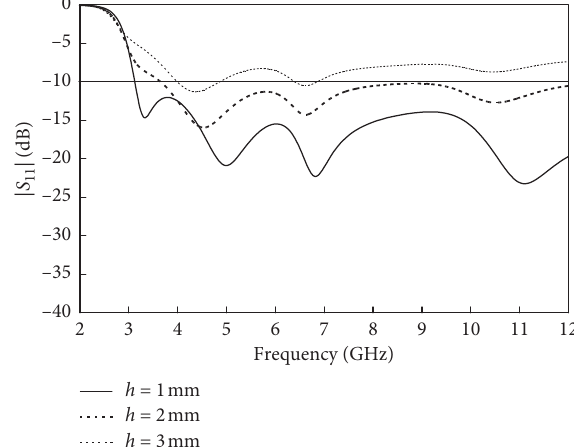
Figure 8: Simulated | S 11 | under varying h of 1, 2, and